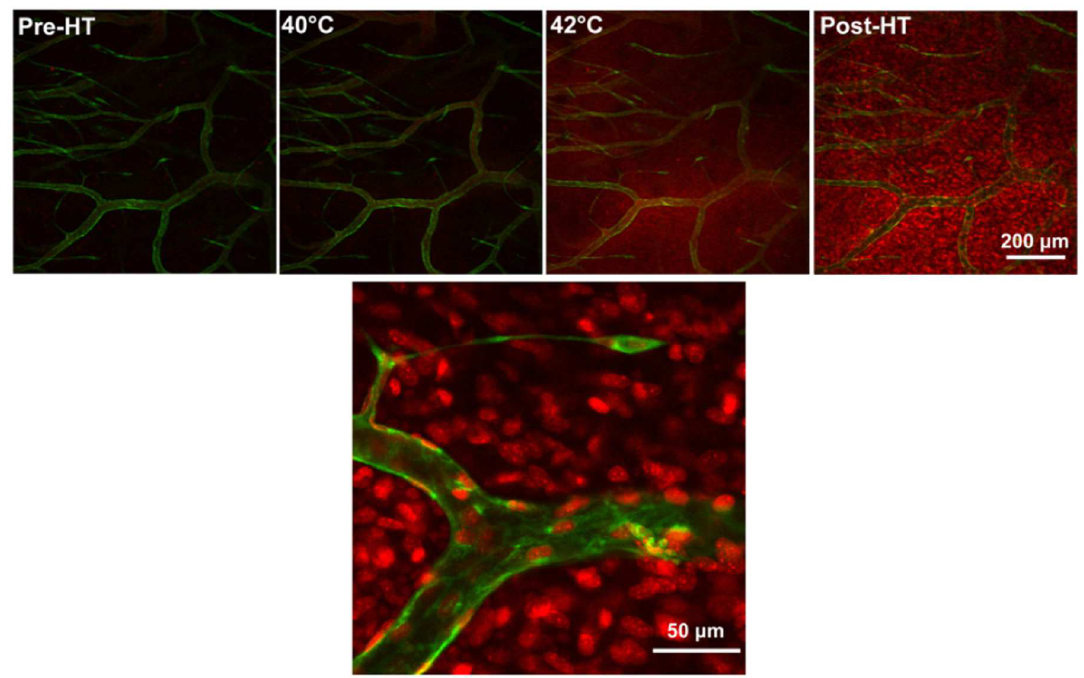
Figure 5. Heat-triggered DXR release from DXR-loaded TSL, and the subsequent intracellular nucleus delivery and accumulation in BFS-1 sarcoma cells and endothelial cells visualized in dorsal skin fold murine BFS-1 sarcoma. Reprinted with permission from [122].